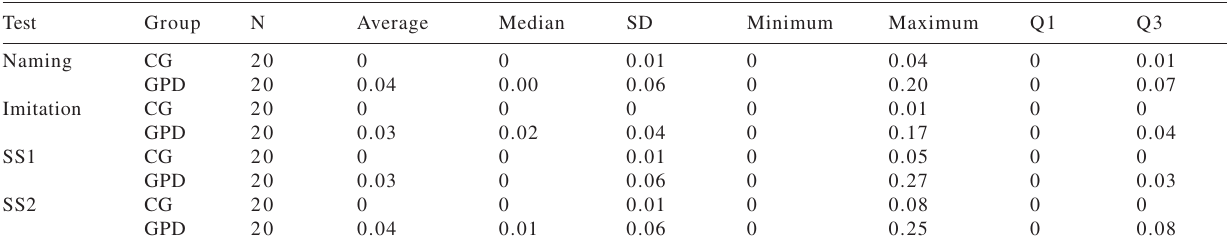
Table 1 - Descriptive statistics of proportions of distortion occurrences in the different